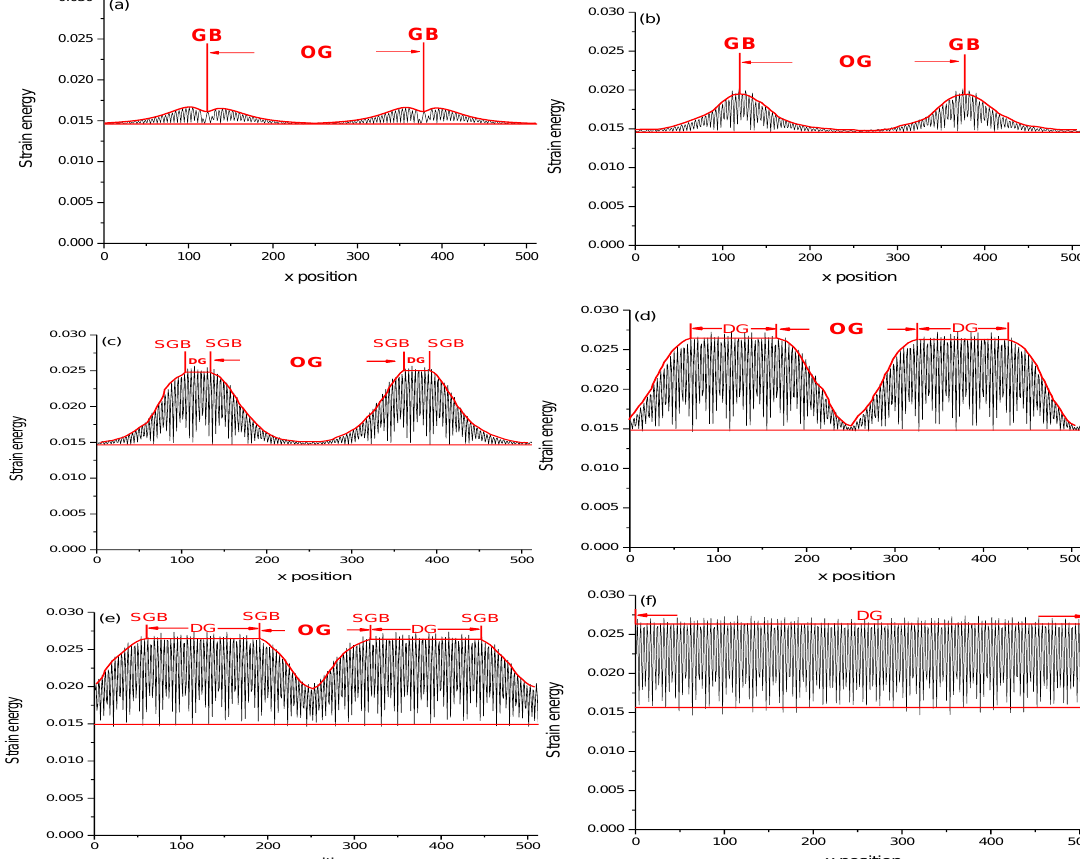
Figure 5. Snapshots of the spatial distribution of the strain energy inside the sample by the PFC simulation is projected to x axis for different strain, which is a sum of the density values over y-axis plotted as a function of x. The red line shows the profile of the spatial distribution of the strain energy. The DG is the width of the deformed grain in these pictures, and the OG is the width of the original grain in these pictures. Strain: ( a ) 0.000, ( b ) 0.0294, ( c ) 0.0516, ( d ) 0.0582, ( e ) 0.0664, ( f ) 0.0732.